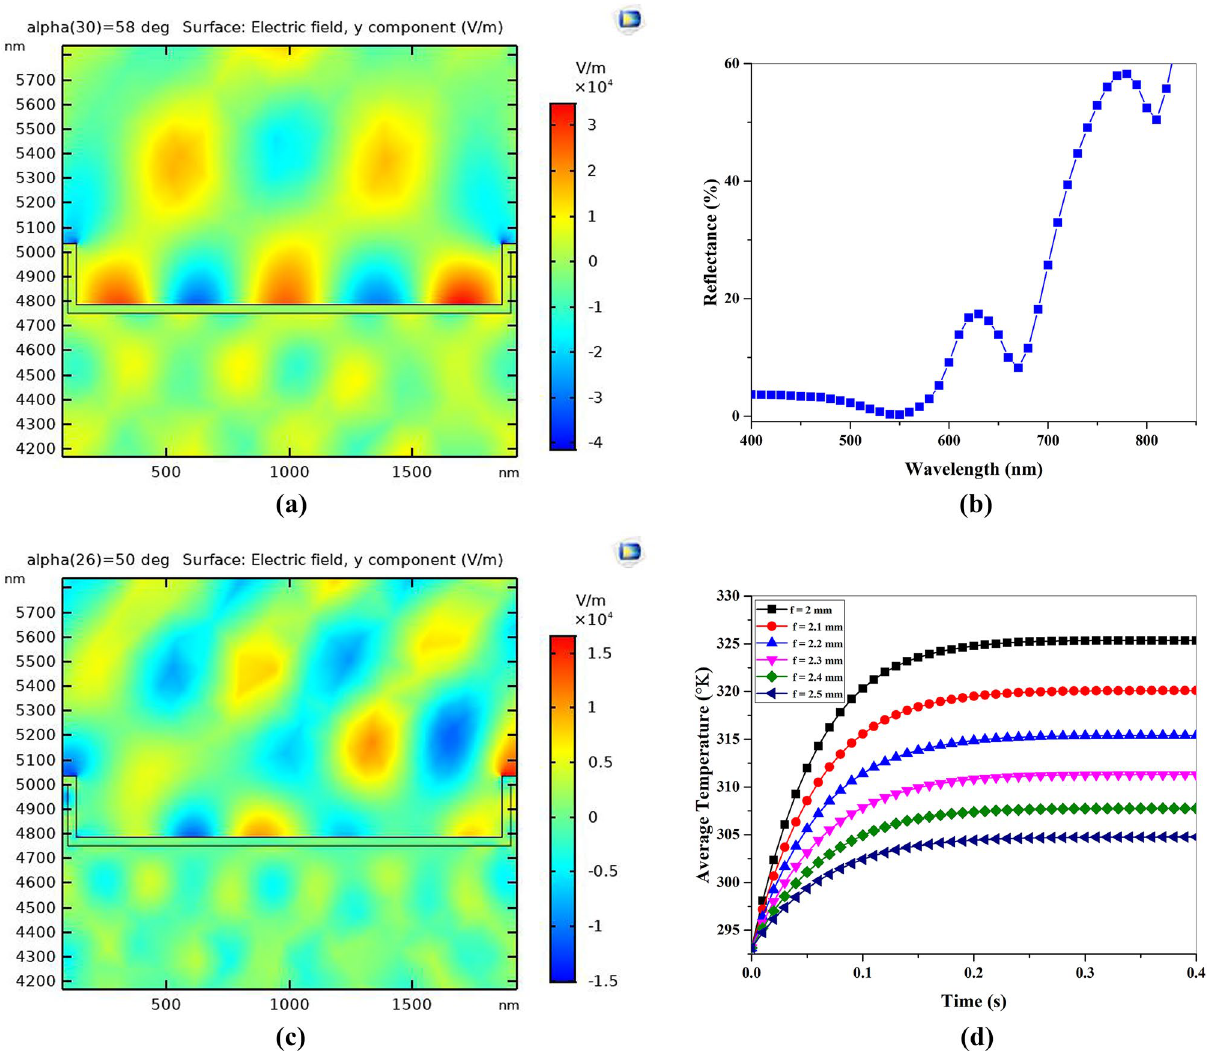
Figure 3. ( a ) Plasmonic SLR for propagation of plane wave at angle of 45° and wavelength of 680 nm, ( b ) transmittance, reflectance and absorption of the first order diffraction of plane waves for the single unit cell. ( c ) Plasmonic SLR for propagation of plane wave at angle of 45° and wavelength of 532 nm and ( d ) the average temperatures distribution across the sample for different distance of the laser focal point